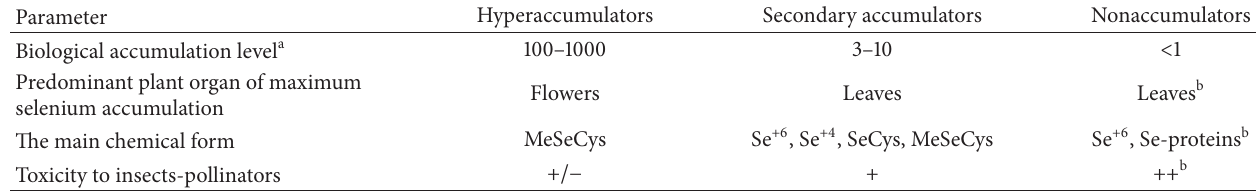
Table 1: Peculiarities of Se accumulation by plants and effect on insect pollinators in conditions of high Se status